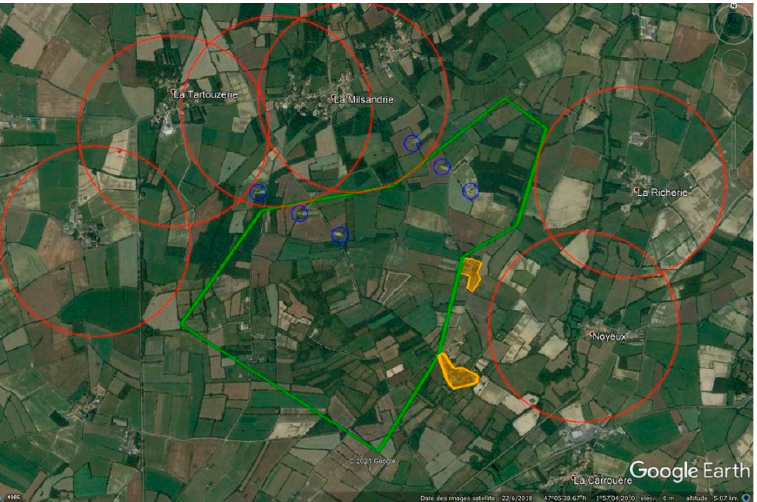
Figure 4. The authorized flight area is delimited with the green line. The small blue circles are the wind turbines. The red circles border the populated zones. The three wind sectors (WSs) are shown in green, peach, and pink (see text for more details).